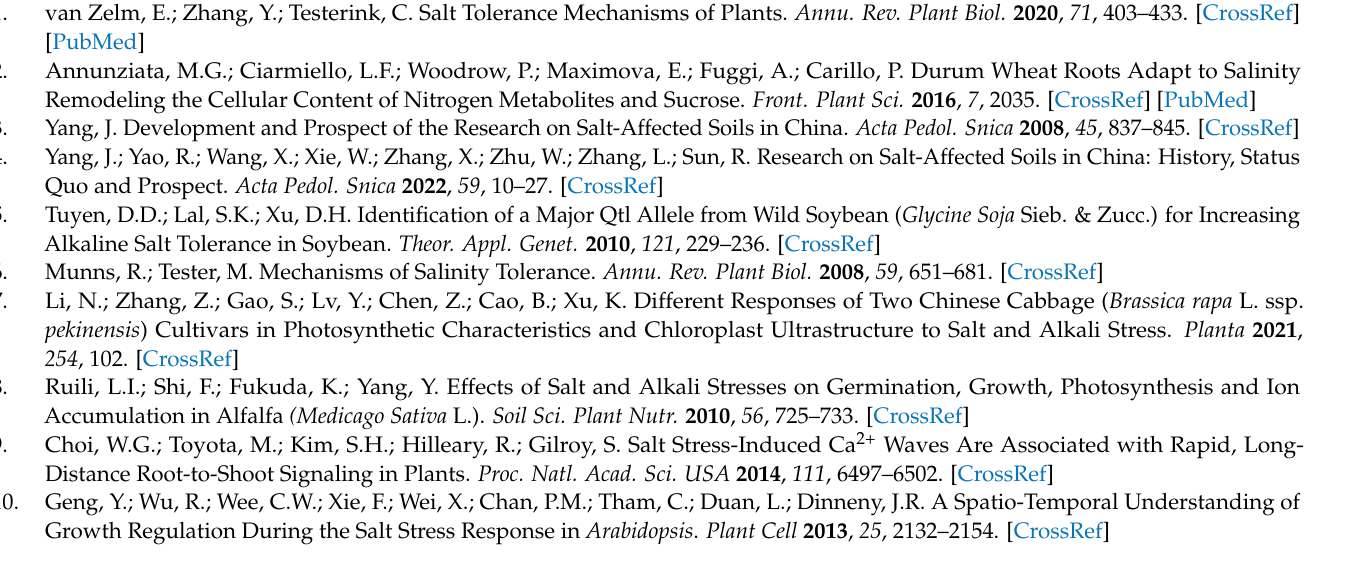
Table S2: The sequencing results of 18 RNA libraries; Table S3: Differentially expressed genes on different groups; Table S4: The differentially expressed genes for further functional analysis; Table S5: Target pathways and annotated DEGs; Table S6: Fifty-five DEGs overlapped on multiple